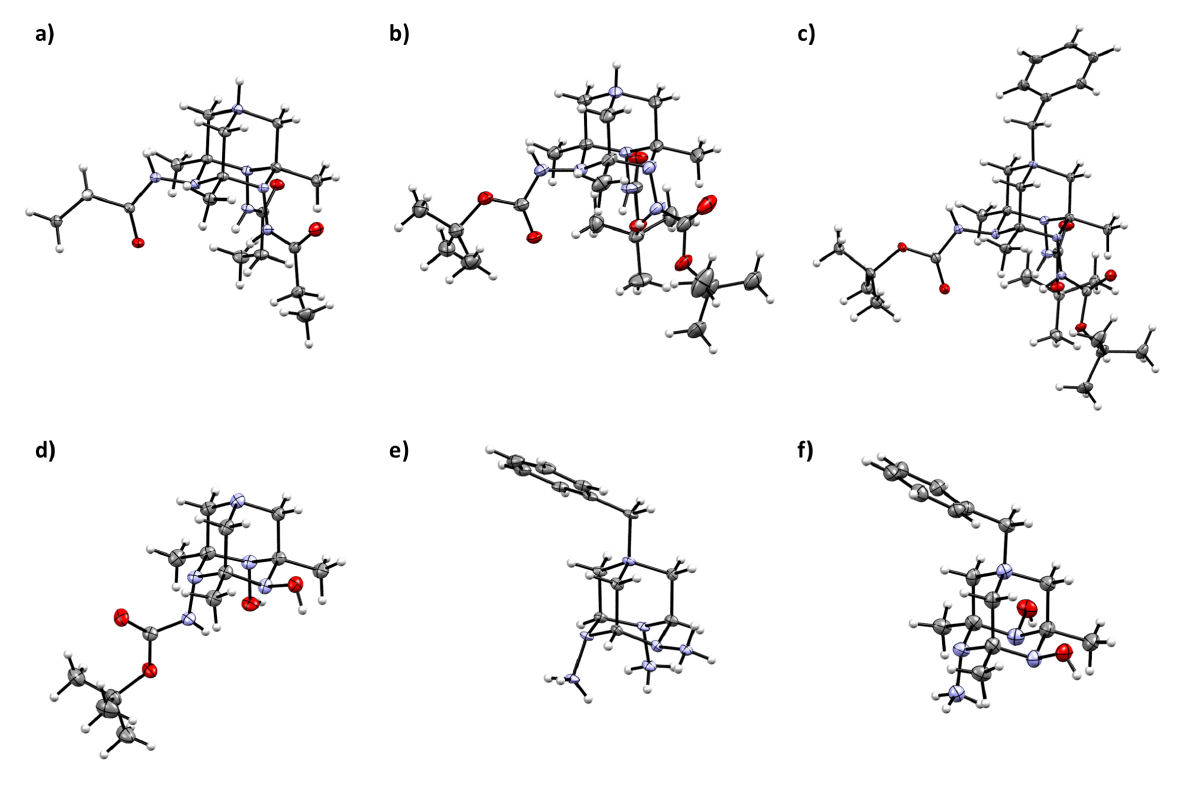
Figure 2: General view of the 1,4,6,10-tetraazaadamantane motif in X-ray structures of the obtained N -TAAD derivatives (representation of non- hydrogen atoms as thermal ellipsoids at 50% probability level). Anions and crystal-solvate molecules are omitted for clarity. (a) 4a ·HCl·H 2 O·MeOH. (b) 4c ·HCl·3.5MeOH. (c) Bn- 4c ·3CD 3 OD (bromide salt). (d) 8a . (e) 19e ·3HCl·H 2 O. (f) 21 ·HCl·2H 2